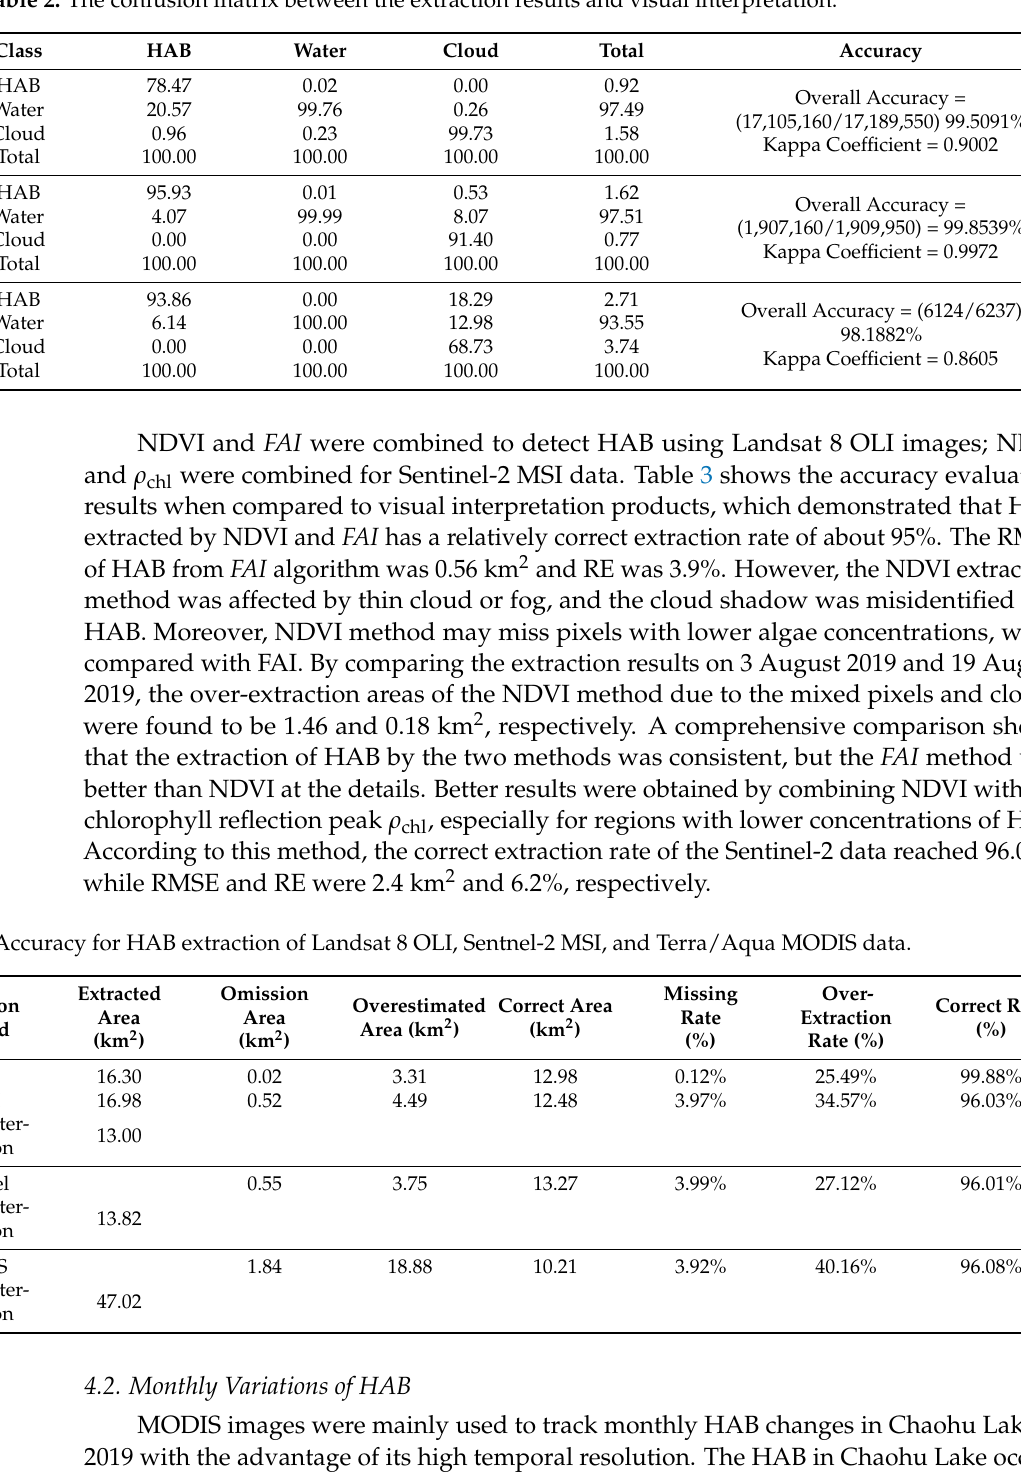
Table 2. The confusion matrix between the extraction results and visual interpretation.